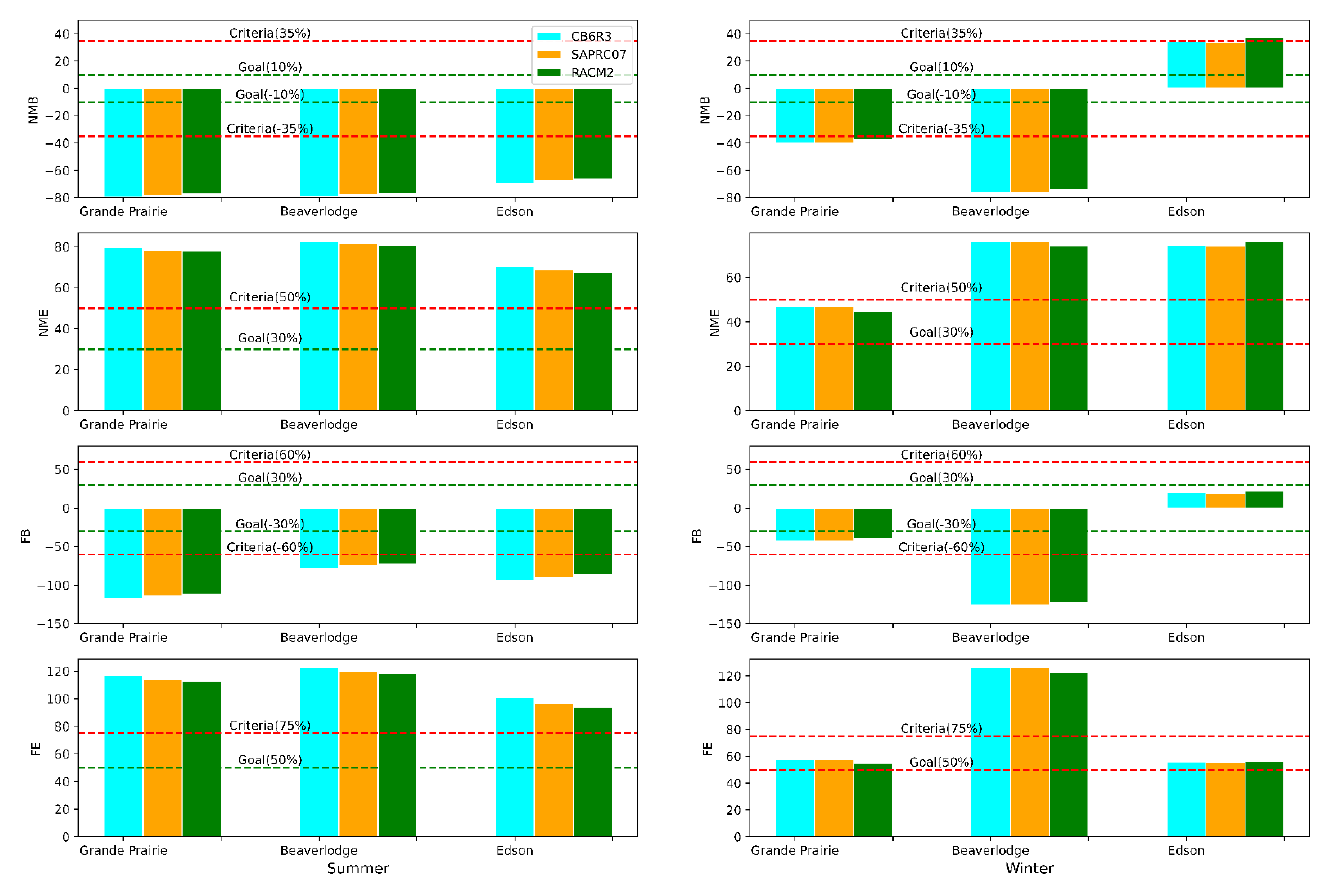
Figure 10. PM 2.5 model performance as measured by NMB, NME, FB, and FE at three ambient Figure 10. PM 2 . 5 model performance as measured by NMB, NME, FB, and FE at three ambient mon- itoring stations in summer ( left ) and winter ( right ). monitoring stations in summer ( left ) and winter ( right